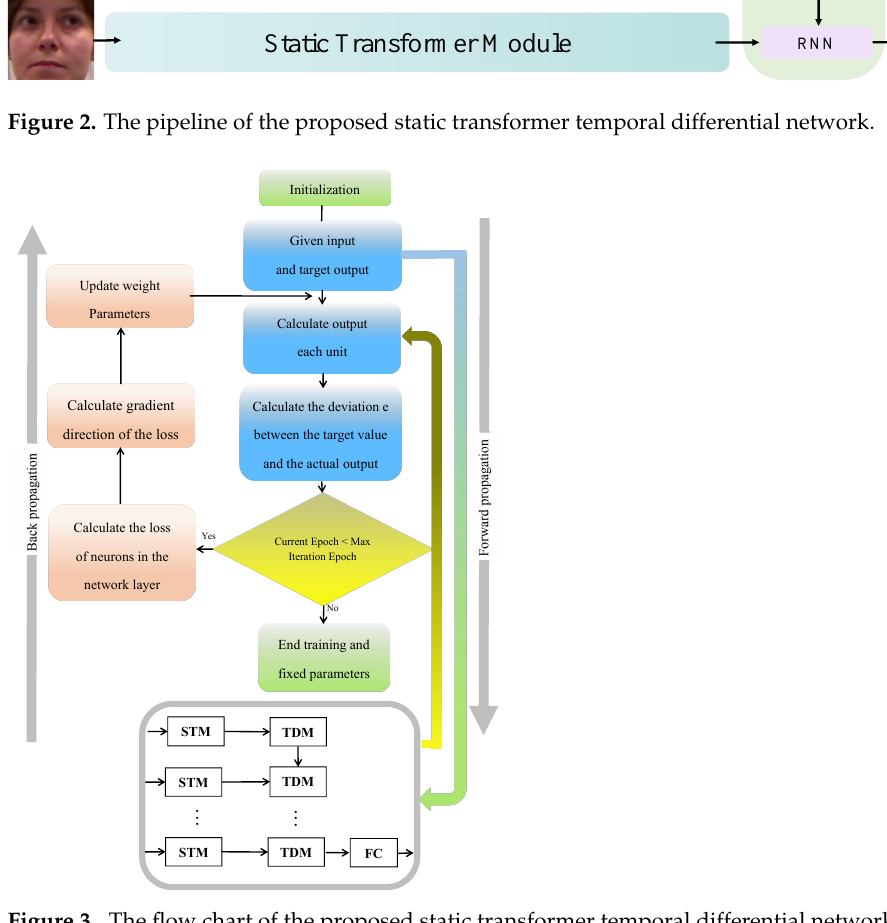
Figure 3. The flow chart of the proposed static transformer temporal differential